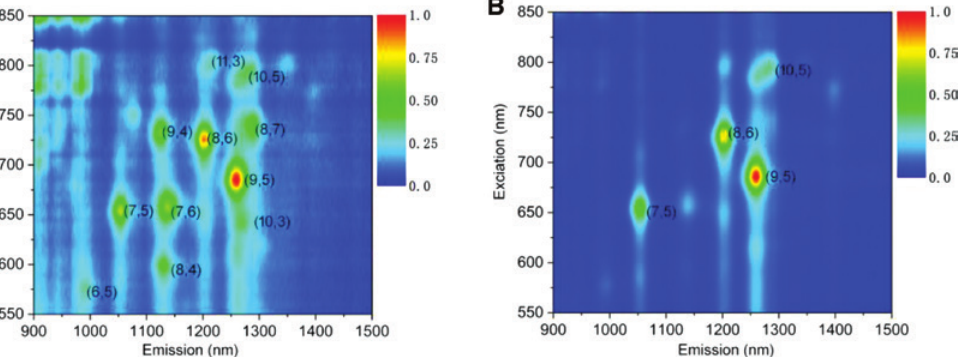
Figure 2: PLE maps of pristine SWCNTs and PFT-sorted s-SWCNTs. (A) Represent the pristine SWCNTs, and (B) represent PFT-sorted s-SWCNTs,